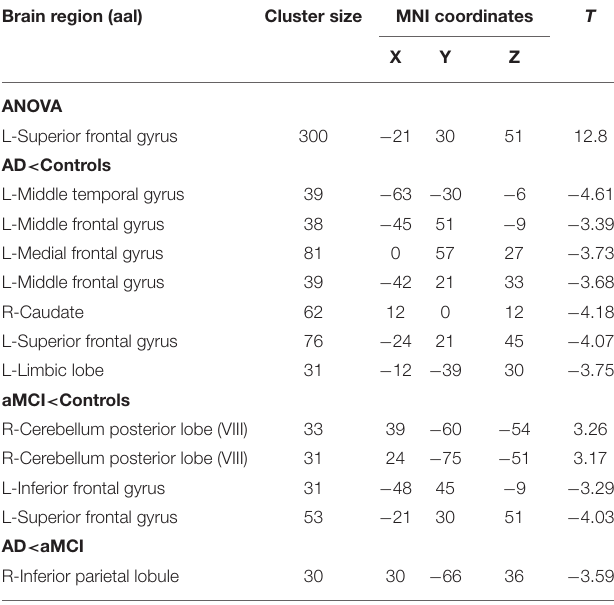
TABLE 3 | Regions showing resting state functional connectivity (rs-FC) changes in cerebellum right crus